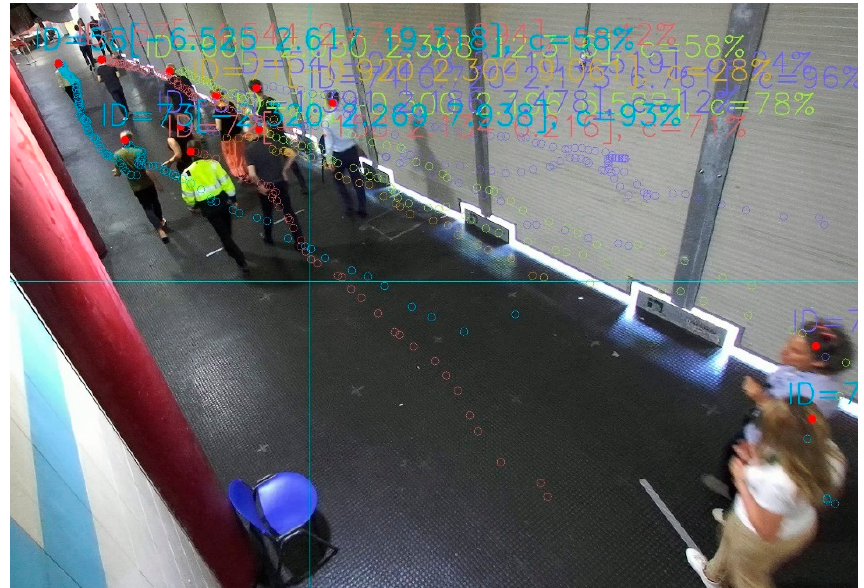
Figure 14 . Run of the group of 12 persons tracked (red dots at head position) in 3D Video. Figure 14. Run of the group of 12 persons tracked (red dots at head position) in 3D